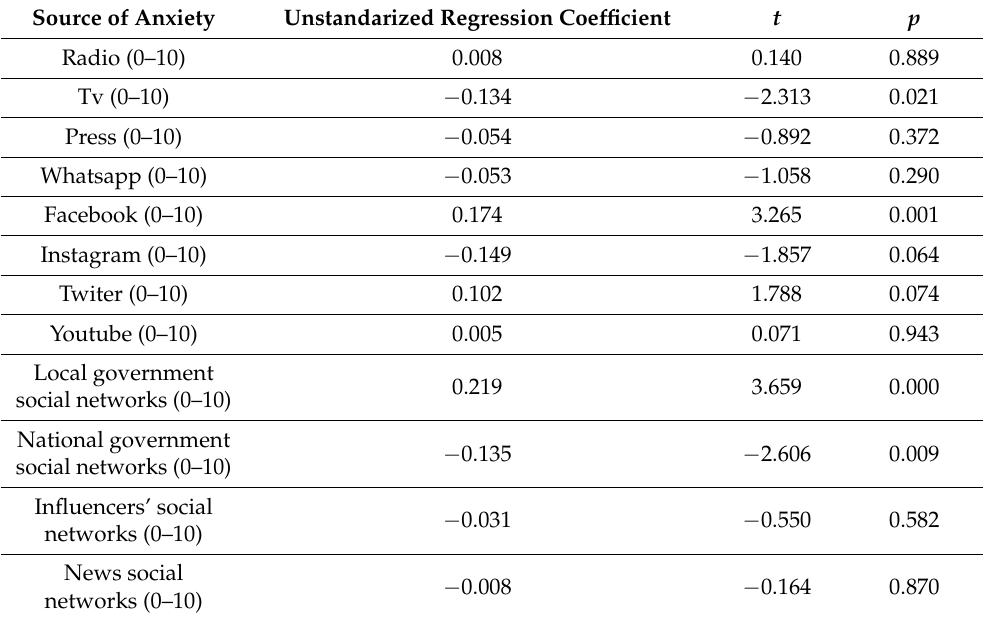
Table 4. Multiple regression: impact of social networks on anxiety